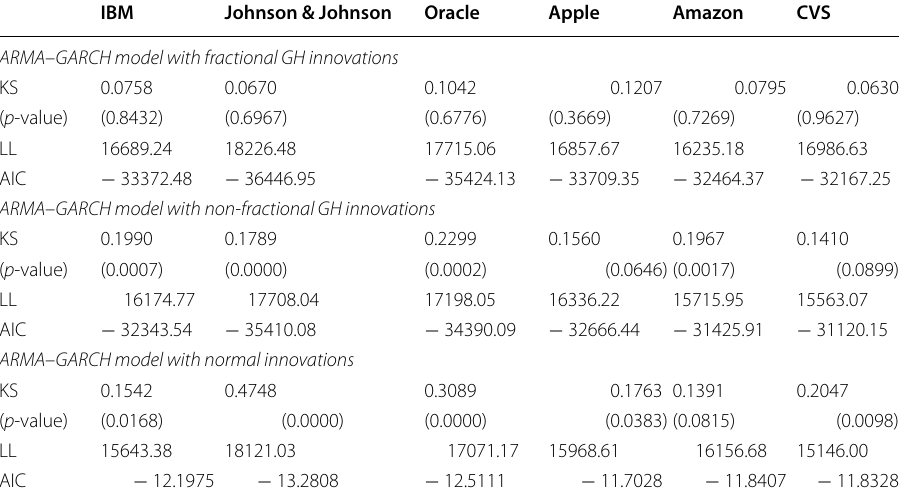
Table 5 Goodness-of-fit tests for ARMA–GARCH